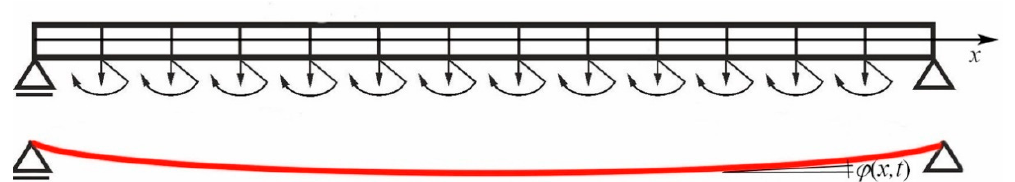
Figure 6. A beam equipped with translation/rotation sensors to better sense local stiffness losses in the beam axis rotations φ ( x , t ).